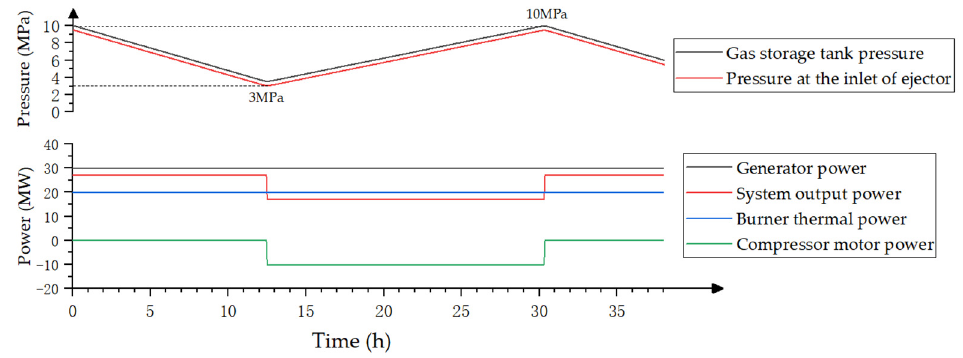
Figure 7. Operating parameters under continuous-output conditions.